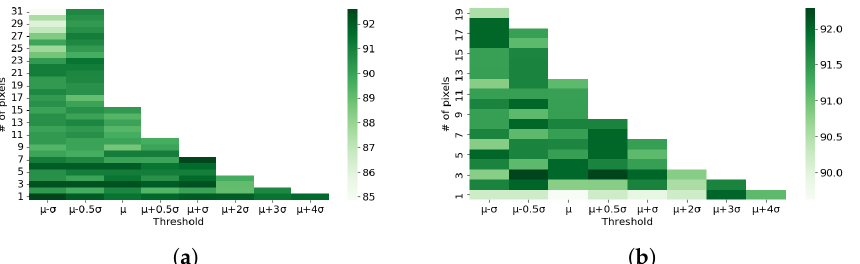
Figure 9. Heat maps of average CV validation accuracy array for selection of optimum T and Num parameters for ( a ) horizontal and ( b ) vertical